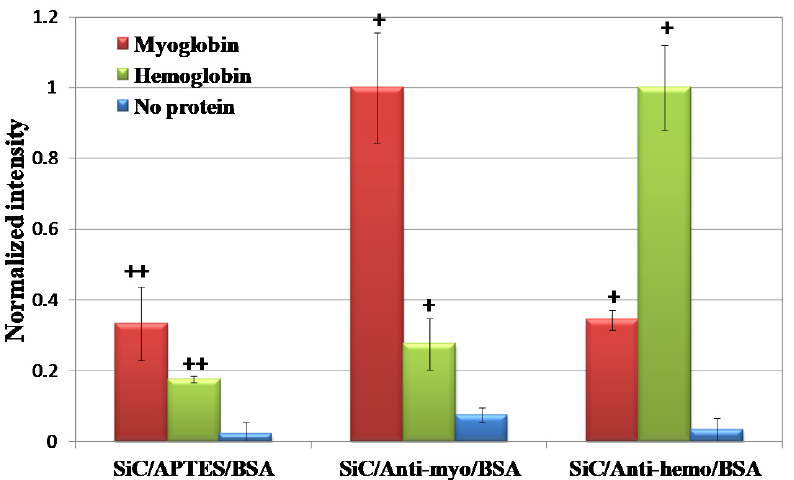
Figure 8. Normalized fluorescent intensity of Alexa-Fluor 488-labeled myoglobin and hemoglobin bound to APTES ( left ), anti-myoglobin ( center ), and anti-hemoglobin immobilized on SiC ( right ) with their respective controls. The results are expressed as the sample distribution of the mean ( x ) and standard error of the mean ( σ M), and normalized to the positive control experiments in each test. + denotes p -values < 0.05 with respect to the antibody immobilized control and ++ denotes p -values < 0.05 with respect to the surface after APTES modification [19].